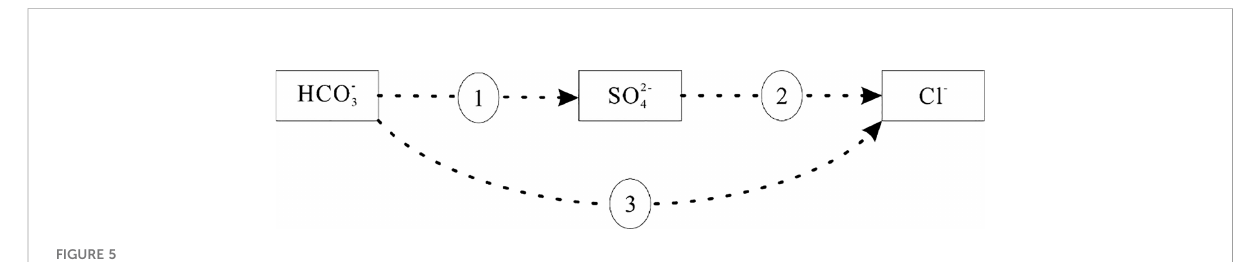
FIGURE 5 Three paths of groundwater chemical